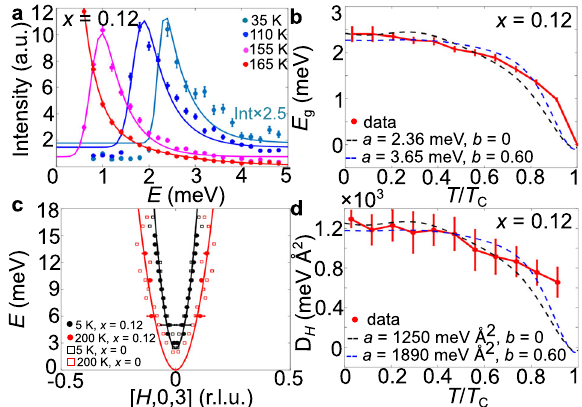
Fig. 4 Inelastic neutron scattering results of Co 3 Sn 2- x In x S 2 ( x = 0.12). a Select energy dependence of the spin excitations at T = 35, 110, 155, and 165 K (see supplementary information for fi t details). b Temperature dependence of the spin wave gap and fi tting results with different parameters with T C = 165 K. c Dispersion curve of the spin wave excitations along [ H ,0,3] at 5 and 200 K fi t to a q 2 - dependence and compared to x = 0 data from 9 as shown in square points. After data analysis 9 , claims a gapless spectrum at 200 K. d Temperature dependence of the in-plane spin-wave stiffness D H and fi tting results with different parameters and T C = 165 K. D H was determined using fi xed E g determined from energy scans (Fig. 4a) and then fi tting the dispersions along H (Fig. 4c). The vertical error bars in ( a ) are statistical errors of 1 standard deviation. The horizontal and vertical error bars in ( b – d ) represent the estimated uncertainty obtained in fi tting